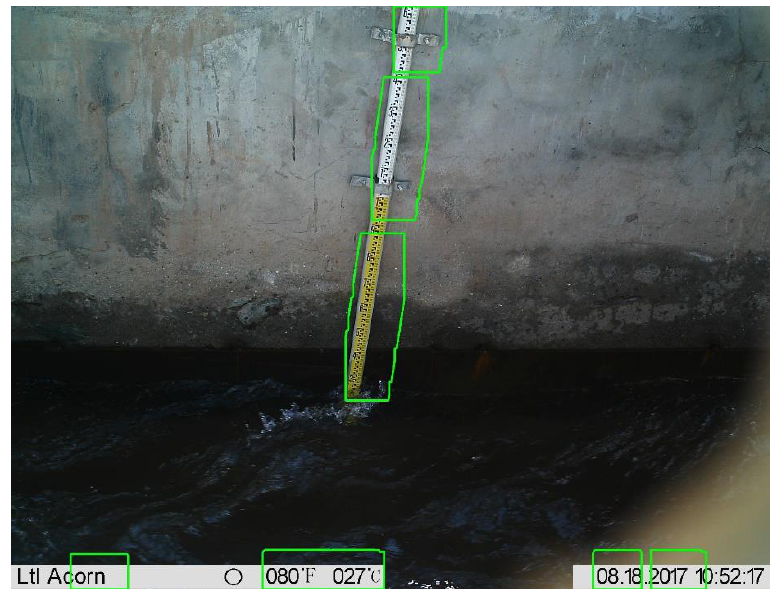
Figure 12. The effect of contour detection from the image in Figure 9b.